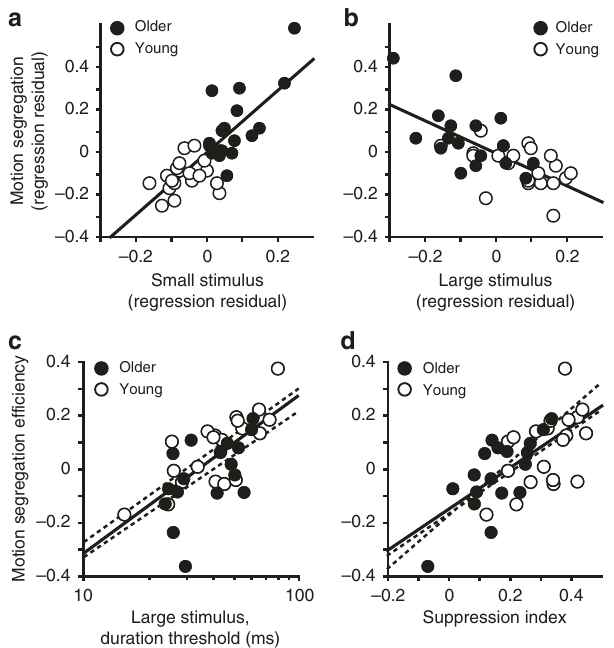
Fig. 4 The relationship between motion segregation and spatial suppression. a The relationship between standardized residuals for motion segregation and small stimulus tasks after regressing thresholds for the large stimulus from both. In both ( a ) and ( b ), higher values indicate worse performance. b The relationship between standardized residuals for motion segregation and large stimulus tasks after regressing thresholds for the small stimulus from both. Motion segregation ef fi ciency is predicted by both c poor motion discriminations of large stimuli and d strong spatial suppression. Here, higher values indicate better motion segregation ef fi ciency. Dashed lines are linear fi ts to young and older adult data. Solid lines are linear fi ts to the pooled data